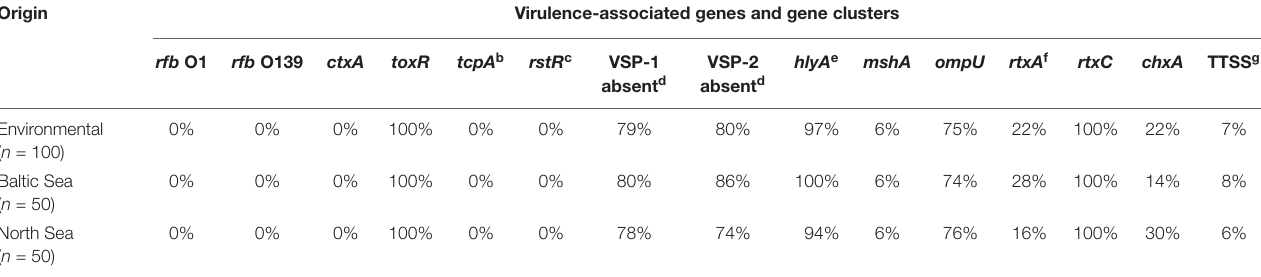
FIGURE 1 | Genetic relationships of Vibrio cholerae non-O1, non-O139 isolates from German coastal waters and from German clinical samples obtained by goeBURST Full MST analysis based on MLST allelic profiles using PHYLOViZ 1.1a. Each sequence type (ST) is displayed as a circle with a size proportional to the number of isolates by which it is represented. The coloring indicates the origin: environmental/North Sea (dark blue), environmental/Baltic Sea (turquoise), and clinical/Germany (dark red). Circles surrounded by a green halo are (sub-) group founders. Single-locus variants (SLVs) are connected via black lines. Gray lines indicate connections with a higher level. The number of differing loci between two STs is shown next to the connection lines. Clonal complexes (CCs) formed at SLV level by North Sea and German clinical (CC1; A ) or Baltic Sea and German clinical (CC2; B ) isolates, respectively, as well as the full Minimum Spanning Tree (MST; C ) are shown. In the full MST, environmental STs forming SLVs to TLVs (triple-locus variants) with clinical STs are marked with a dark red arrow. TABLE 2 | Presence/absence of virulence-associated genes and gene clusters in Vibrio cholerae non-O1, non-O139 isolates from German coastal waters based on PCR data. a